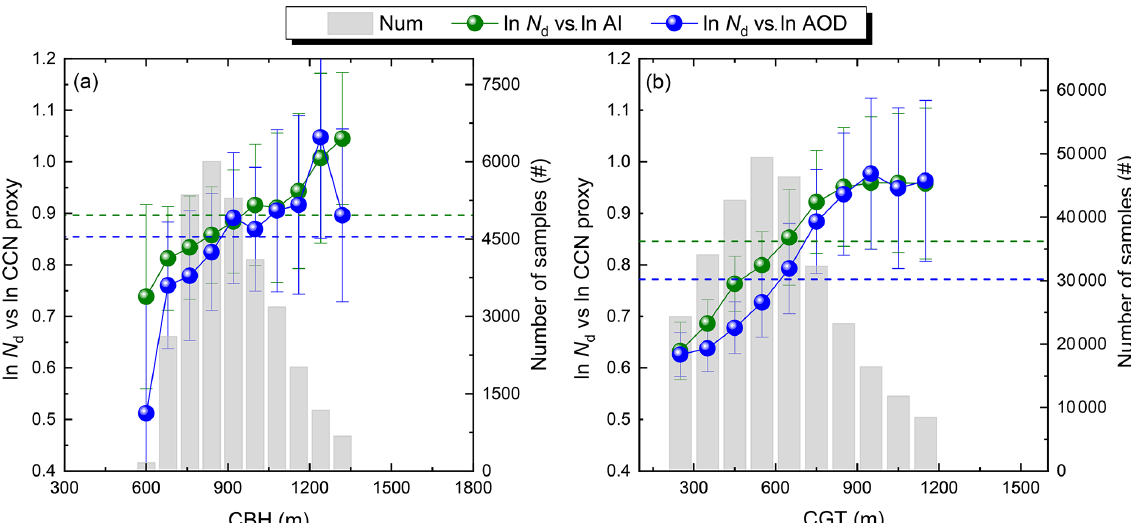
Figure 2. Dependence of the linear regression slopes of ln N d versus ln AOD (blue) and ln AI (green) on (a) CBH and (b) CGT derived via the pre-binned approach. Data are grouped into 10 fixed CBH (CGT) intervals for regressions. Error bars indicate the 95% confidence interval of the linear regression, and the gray bars denote the total number of samples for each CBH (CGT) bin. The corresponding regression slopes computed from the data over all CBH (CGT) bins are shown as horizontal dashed lines (green for AI and blue for AOD). The equivalent figure (Fig. S1) shows similar results based on the all-data